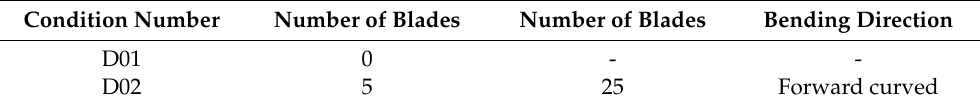
Table 6. Comparison of fan blade settings between the original and optimized ventilators.